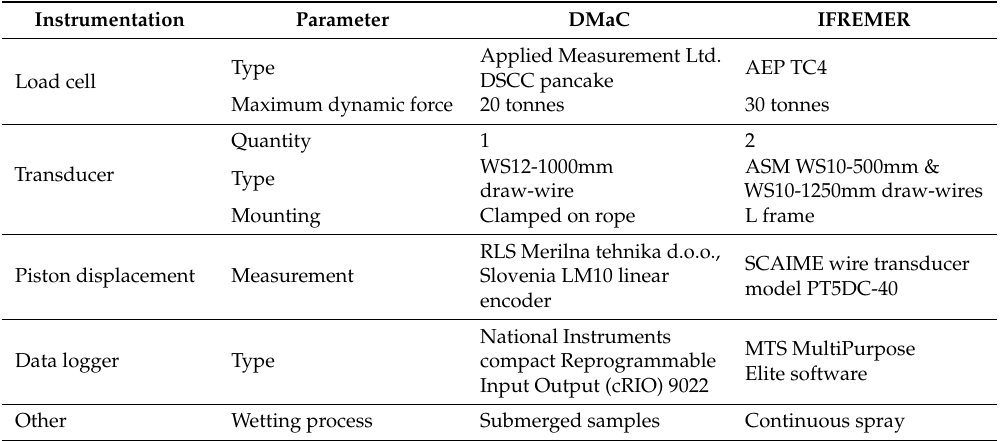
Table 3. Instrumentation at DMaC and IFREMER for Round Robin Testing (RRT)